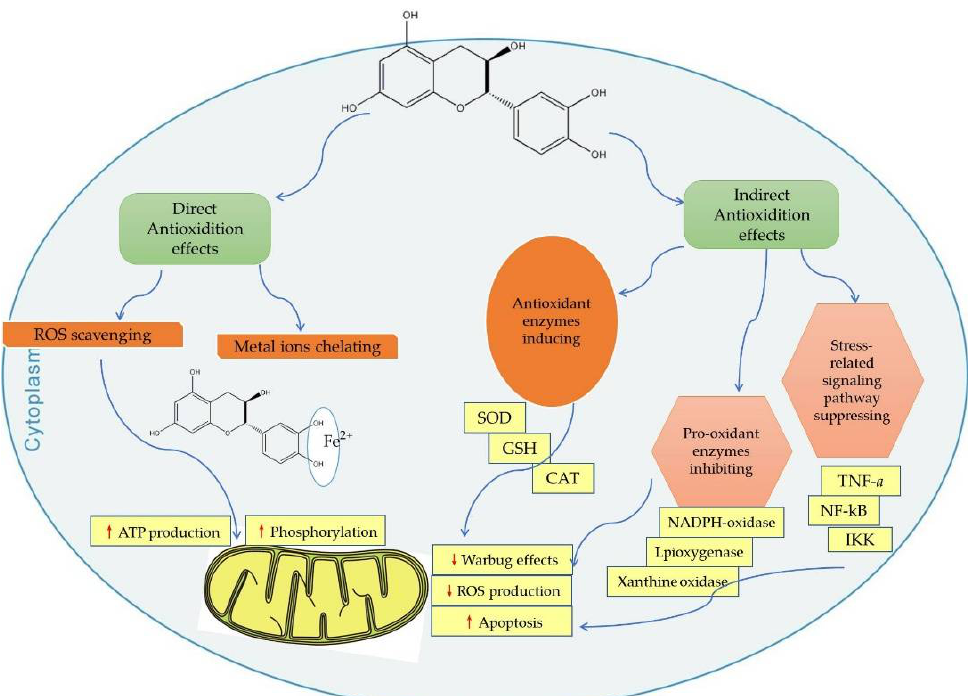
Figure 1. Direct and indirect effects of catechins on mitochondrial functions. CAT, catalase; SOD, superoxide dismutase; ROS, reactive oxygen species; GSH, glutathione peroxidase; TNF-α, tumor necrosis factor alpha; NF-κB, nuclear factor kappa beta; IKK, inhibitory κB Kinase. Red up arrows indicate increasing effect, and red down arrows indicate reducing effect.